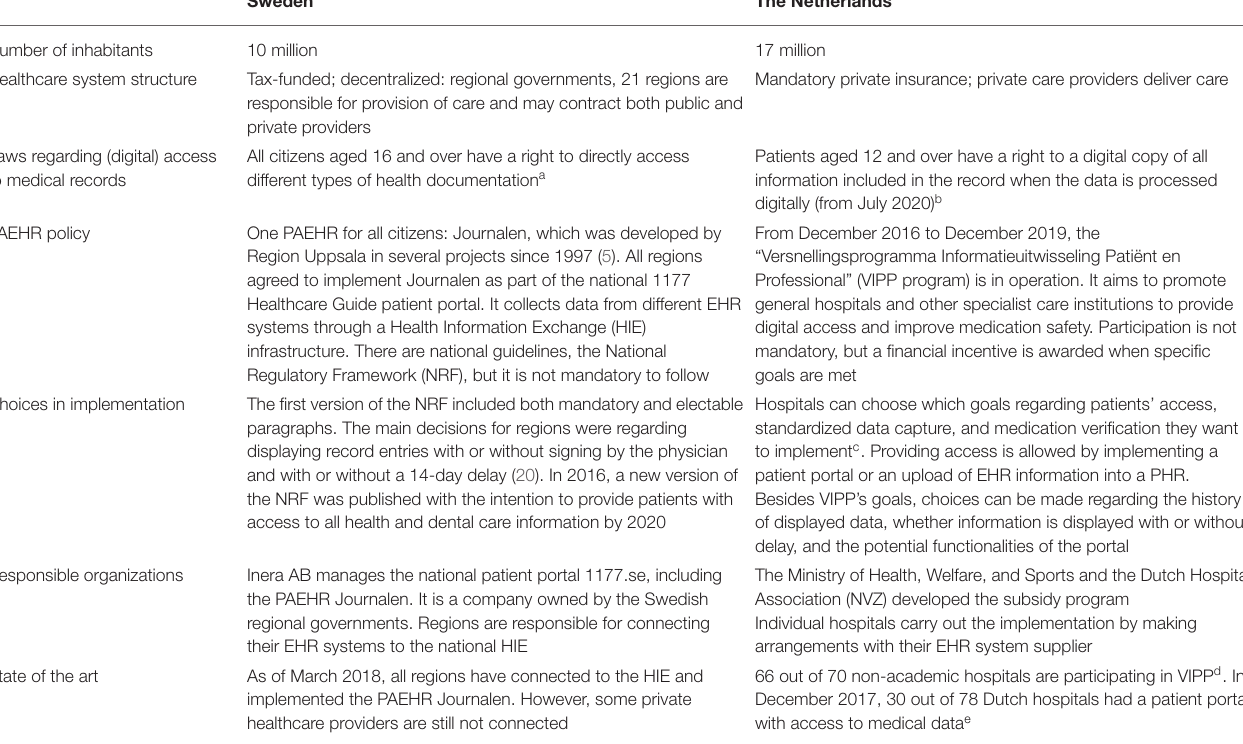
TABLE 1 | Overview of healthcare system structures, regulations concerning access to medical data, and existing patient-accessible electronic health record (PAEHR) policies in Sweden and the Netherlands.